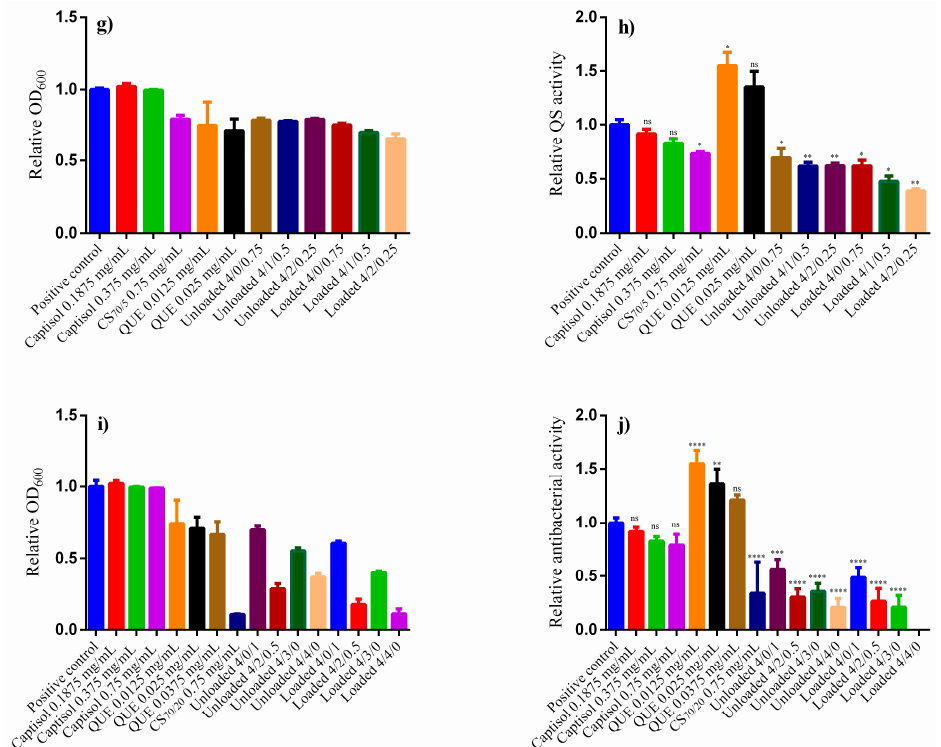
Figure 9. Influence of different treatments on the evolution of bacterial growth (OD 600 ), florescence intensity and relative light unit (FL/OD) of CS 70/5 NPs ( a – c ); of CS 70/20 NPs ( d – f ), respectively. Effect of different formulations on relative bacterial growth (OD 600 ) and relative QS activity of CS 70/5 NPs ( g , h ); of CS 70/20 NPs ( i , j ), respectively. (L: loaded NPs, U: unloaded NPs, QUE: quercetin; values represent mean ± SD, n = 3 with eight technical replicates, statistical significance after ANOVA multiple comparison analysis with respect to the positive control: * p < 0.05, ** p < 0.01, *** p < 0.001 and **** p < 0.0001).